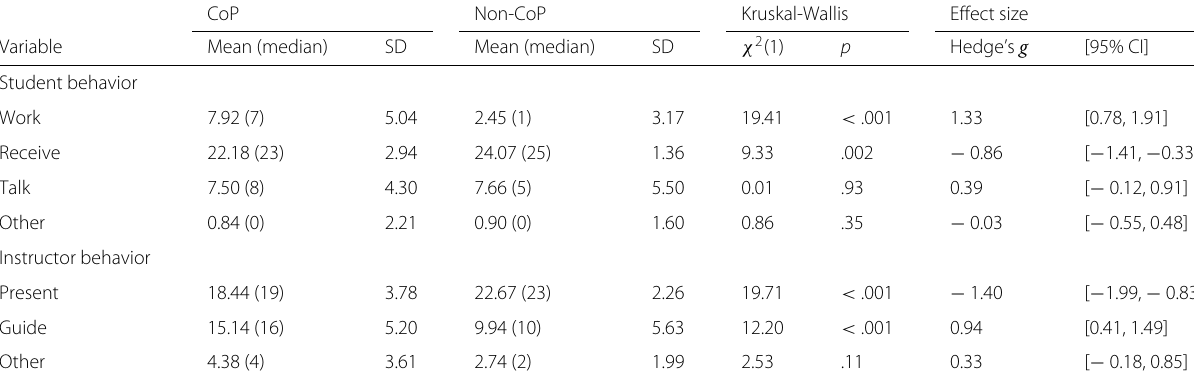
Table 2 Comparisons of central tendency and variation of the total counts of 2-min intervals where behavior, as indicated by the collapsed categories for student and instructor codes, was observed by CoP ( n = 25) and non-CoP ( n = 35) instructors CoP Non-CoP Kruskal-Wallis